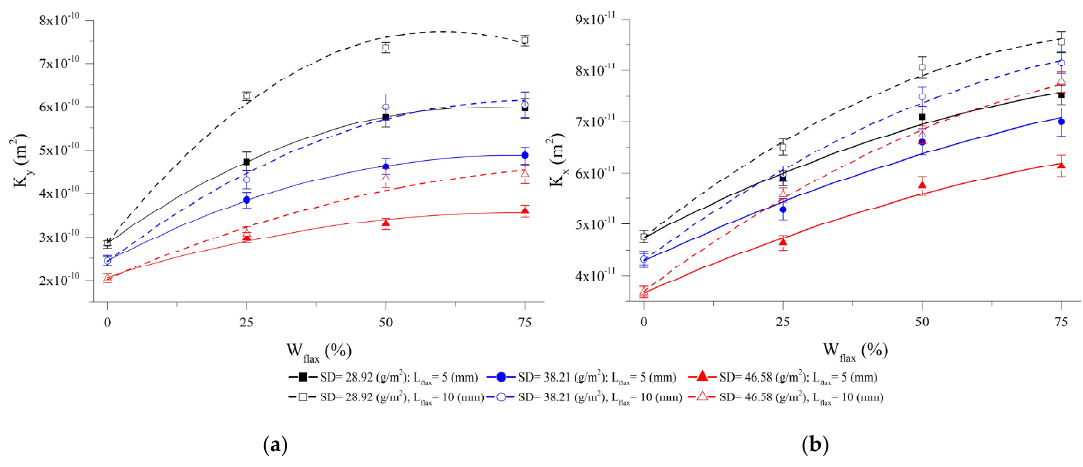
Figure 7. Effect of paper phase parameters on the reinforcement K x ( a ) and K y ( b ) permeability.